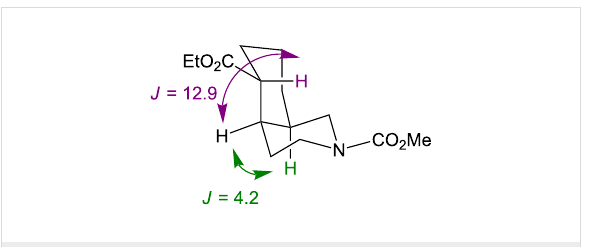
Figure 1: Coupling constants (Hz) in the major diastereoisomer of 15